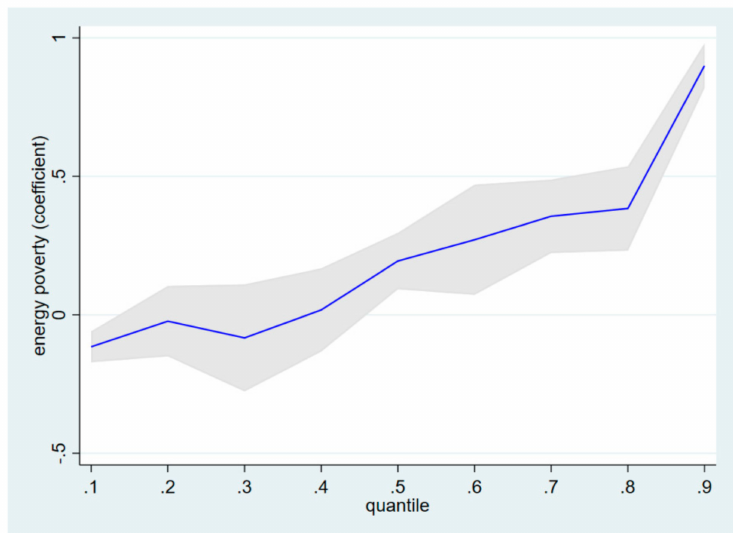
Figure A2. Instrumental variable quantile regression estimates for the impact of energy poverty (EP2) on depression. Notes: the x -axis denotes the 9 conditional quantiles of the CES-D8 depression scores, and the y -axis presents the coefficient estimates of energy poverty measure (EP2). Shaded areas correspond to 95% confidence intervals of quantile